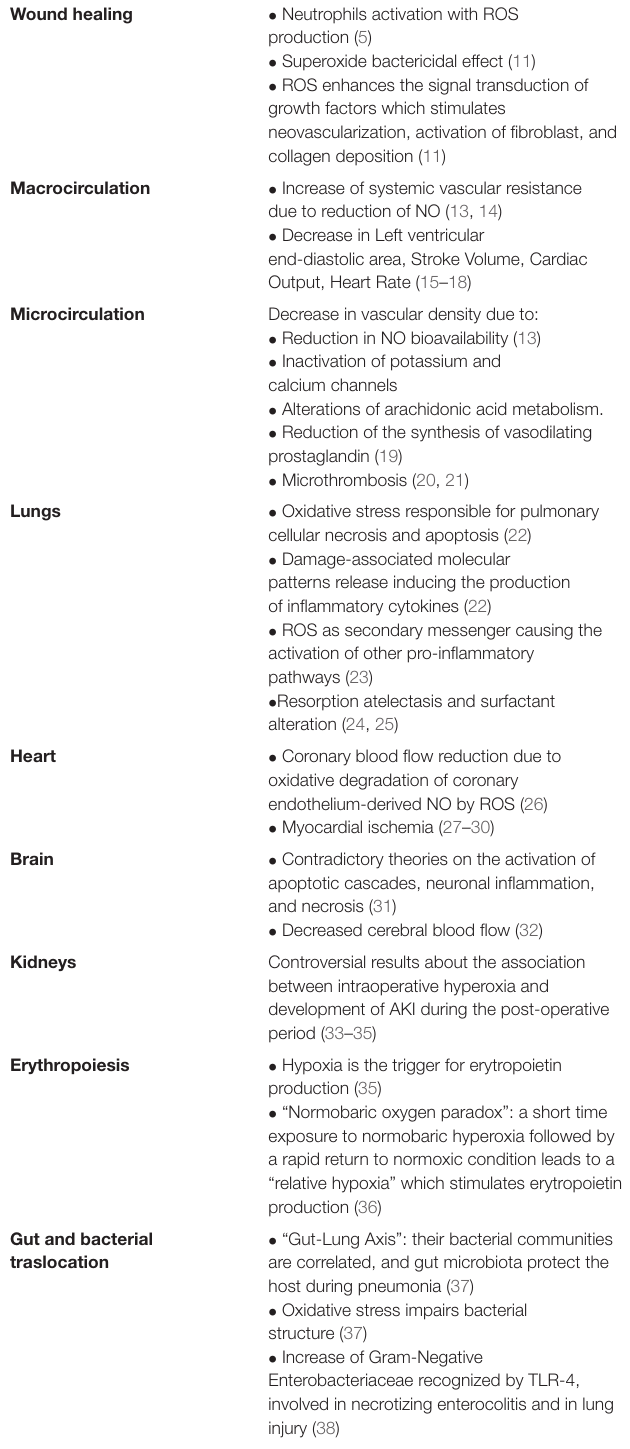
TABLE 1 | Main pathophysiological mechanisms related to hyperoxia effects (see text for details). Wound